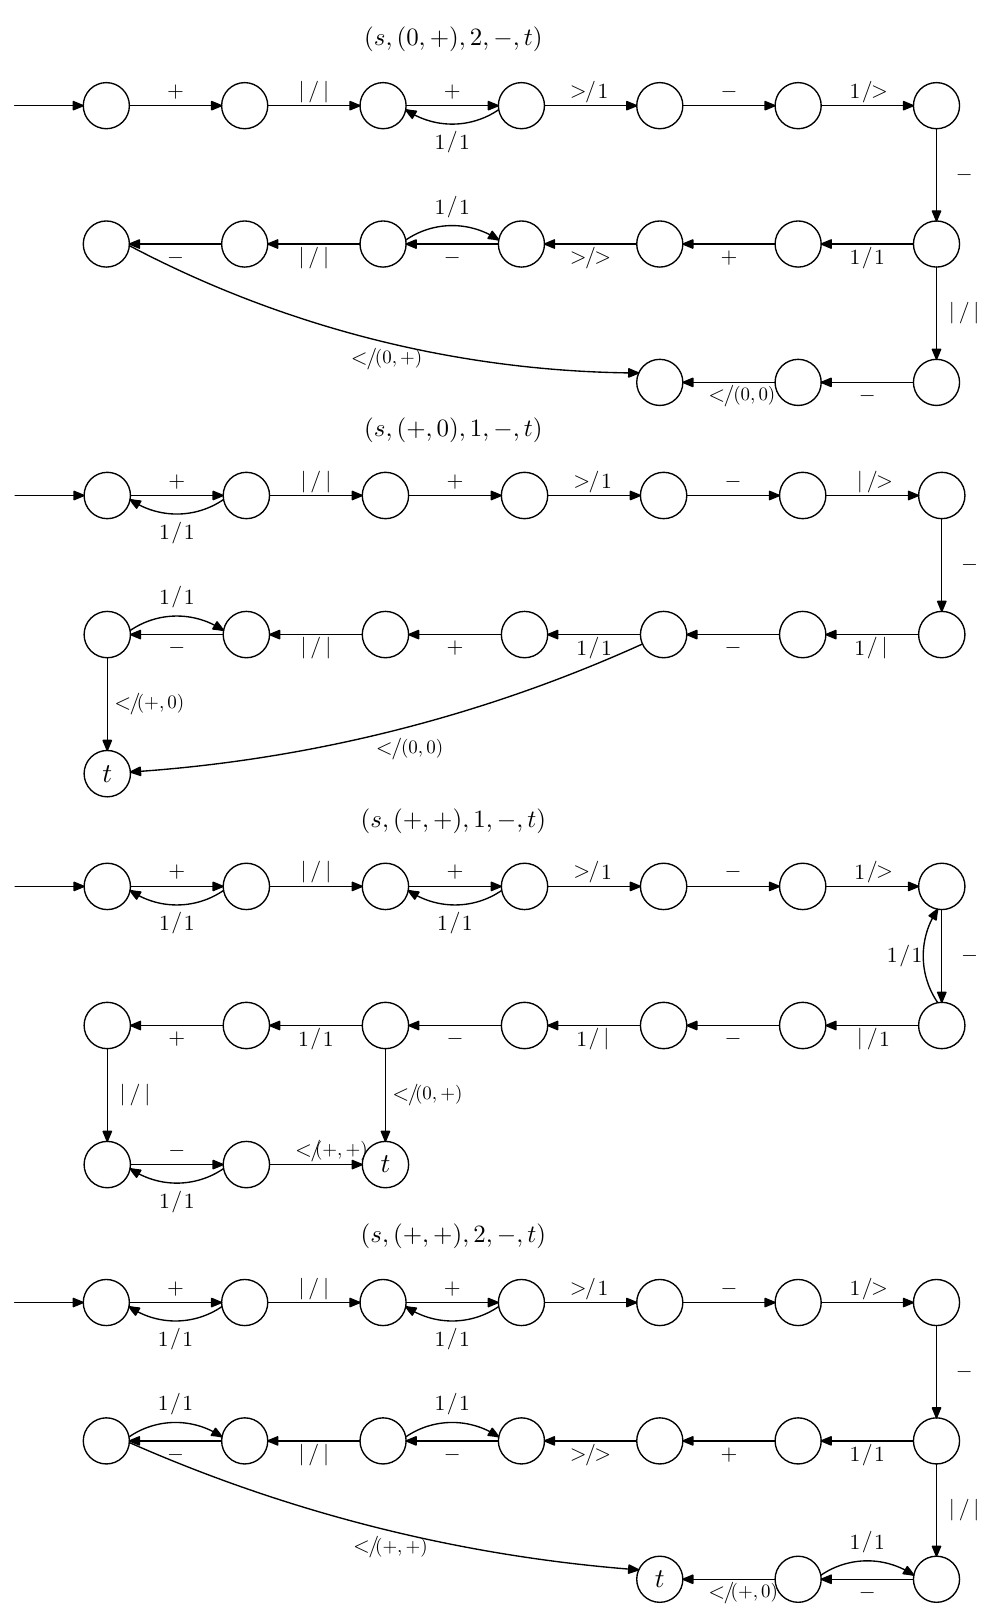
Tab. 2: Sub-routines corresponding to subtraction